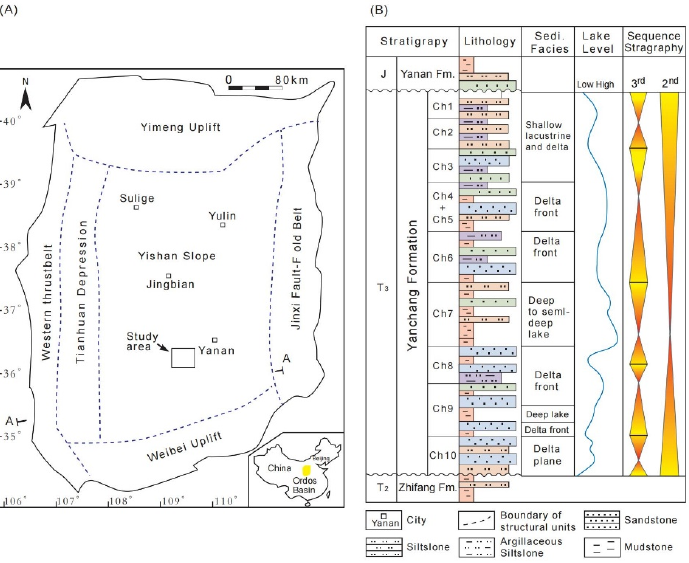
Figure 6. ( A ) Simplified structural units, cross-section, and location map of the Liuluoyu area in the southwest Ordos Basin, China. ( B ) Stratigraphic column of the study area showing the location of the Chang 8 tight oil reservoirs. Ch = Chang; Fm. = formation; and Sed. = sediment (modified from Zhang et al. 2021) [33].